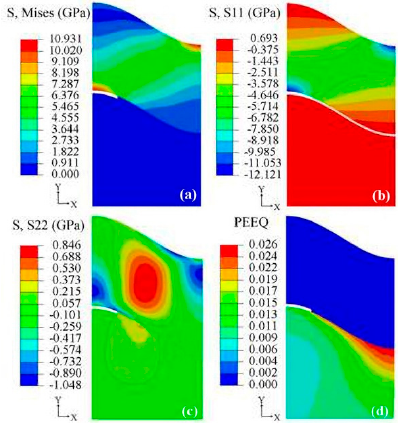
Figure 6. Stress components and equivalent plastic strain (PEEQ) at the ambient temperature considering the interface crack: ( a ) Mises stress, ( b ) S11, stress in x direction, ( c ) S22, stress in y direction, and ( d ) PEEQ, equivalent plastic strain. Reprinted with permission from [57]; Copyright 2017 ASME.